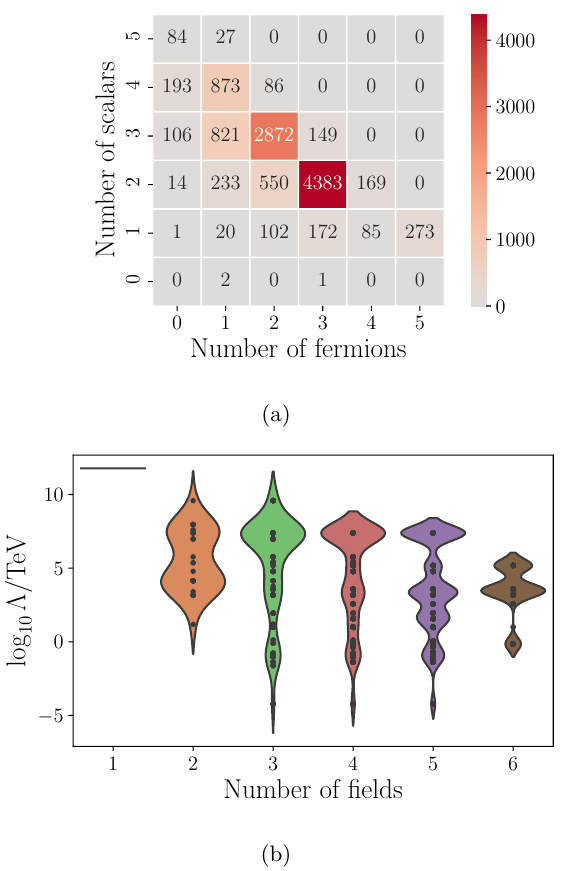
Figure 13. (a) The number of filtered models containing different numbers of exotic scalar and fermion fields. Most models contain five fields, with the most common combination being three fermions and two scalars. The fermion-only models are associated only with Weinberg-like opera- tors. (b) The rough upper bound on the new-physics scale Λ shown against the number of exotic fields introduced in the models. The black dots show the upper bound on the scale of the new physics for each model. A given black dot generally denotes more than one model. Each strip is a smoothed histogram of the number of models having a given Λ as the new-physics upper bound for the specified number of fields. A sizeable class of models are testable at current or future collider